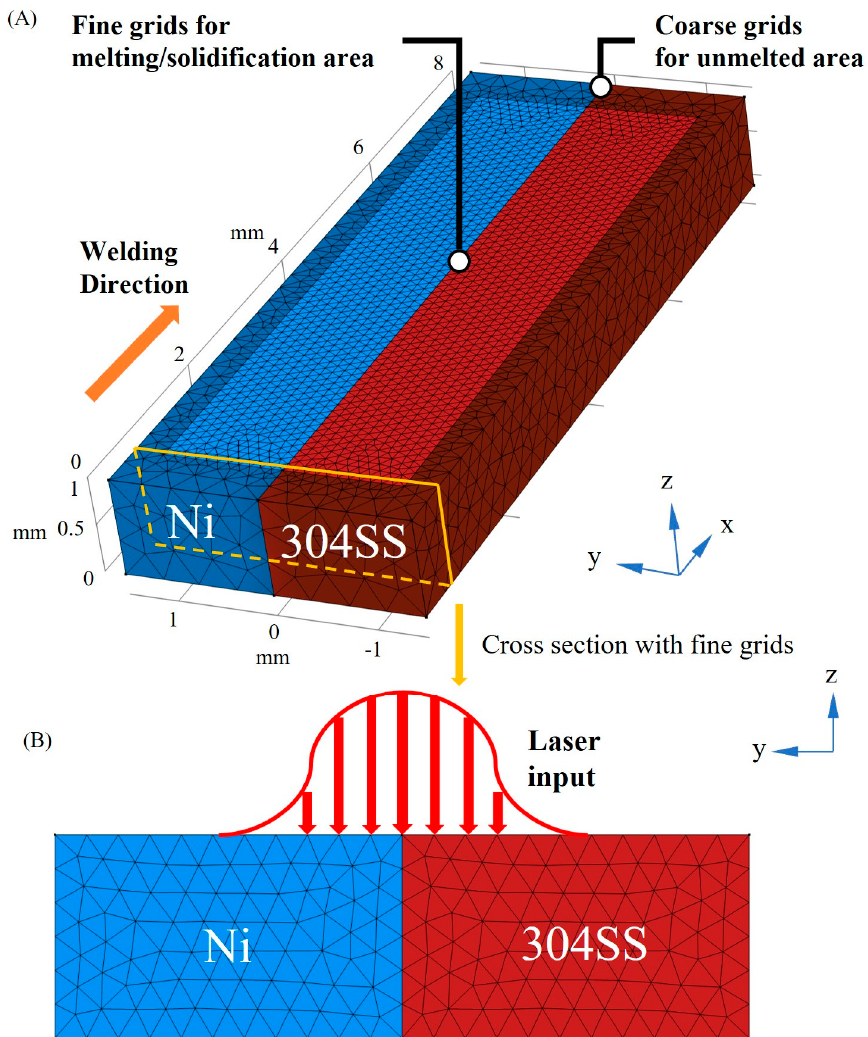
Figure 1. Grid distribution in the numerical model. ( A ) 3D view; ( B ) Cross-section with fi ne grids.